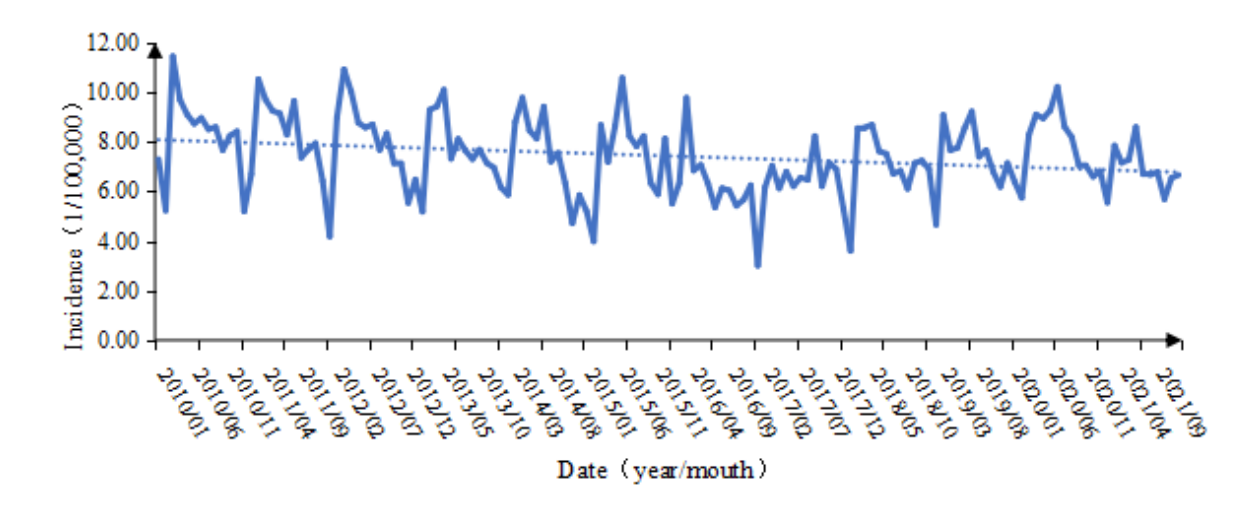
Figure 2. Time series of tuberculosis incidence in Changde City from 2010 to 2021. A total of eight meteorological factors and six ambient air pollutants were selected in this study, and their basic descriptions are shown in Table 2. Table 2. Basic descriptions of meteorological factors and ambient air pollutants in the Changde City from 2010 to 2021.